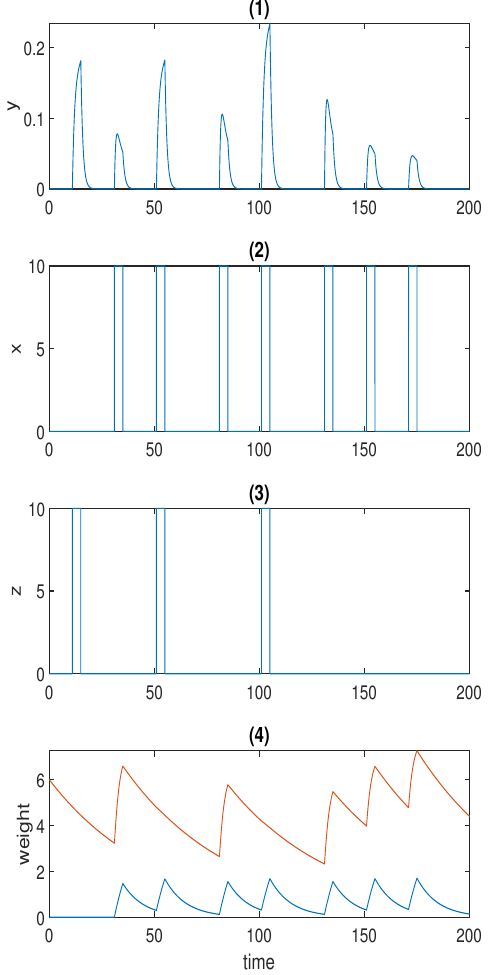
Figure 9. An example to illustrate the effect of change in parameter values on the model with forced dissociation. a = 2, α yx = 2, α yz = 4, α xyz = 4, α ux = 0.45, α vx = 1.5, β u = 0.1, β v =